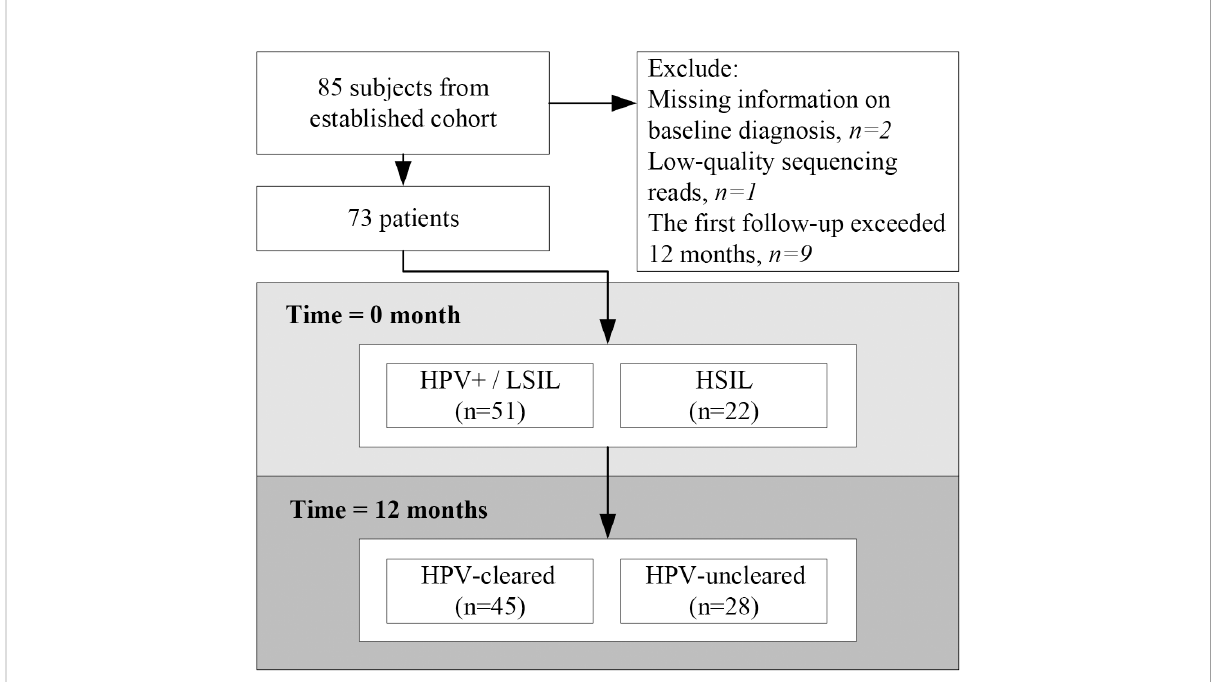
FIGURE 1 Flow chart of the study design. Seventy-three patients with histologically con fi rmed cervical lesion at baseline entered this study. Follow-up cytology and human papillomavirus (HPV) tests were performed every 6 months to determine whether subjects had cleared HPV infections or not at 12